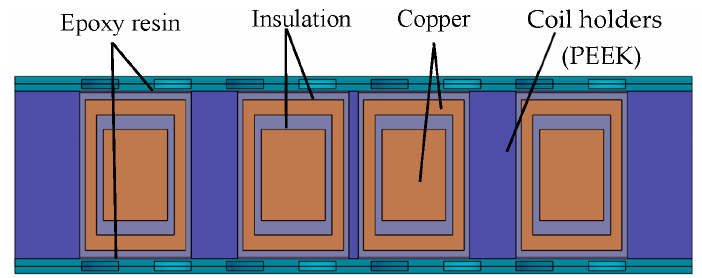
Figure 11. Equivalent winding model.